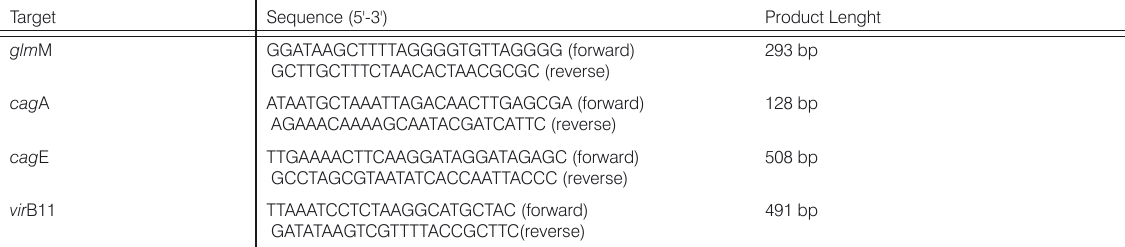
Table 1. Primer sequences and expected length of PCR amplicons in the